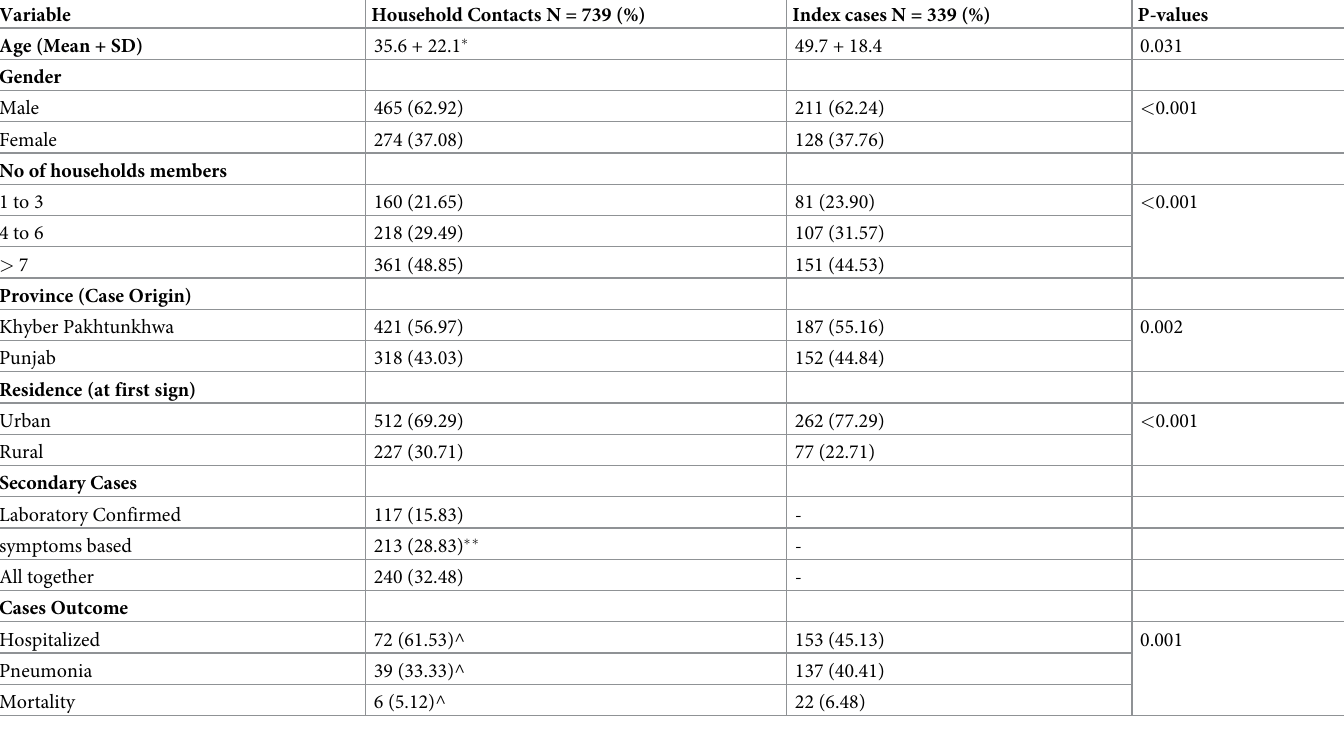
Table 1. Description of Covid-19 households and their index cases in Khyber Pakhtunkhwa and Punjab Province of Pakistan, May 17th, 2020—January 15th, 2021.